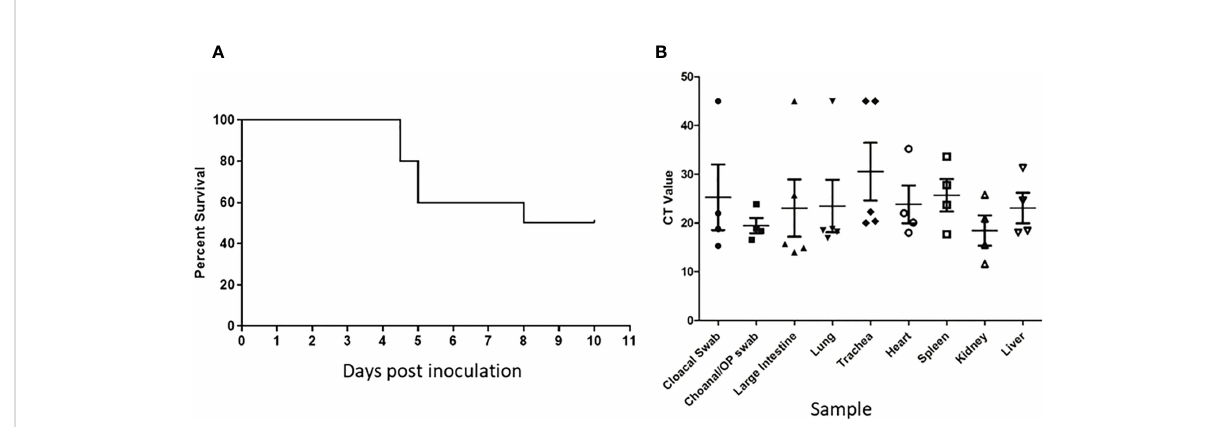
FIGURE 1 Unexpected deaths following H7N9 infection. Survival curve (A) and RT-qPCR detection of H7N9 systemic infection (B) following ONO inoculation of SPF chickens with A/Anhui/1/13 (H7N9). (A) Following inoculation of ten 16-week old SPF chickens with 10 7.7 EID 50 of A/Anhui/1/ 13 (H7N9), fi ve chickens either died or were humanely killed between day 5 and 8 pi. (B) Swab and tissue samples taken upon necropsy from the fi ve chickens that died/were humanely killed, were subjected to RT-qPCR analysis of the in fl uenza M gene to assess the degree of systemic infection in the affected